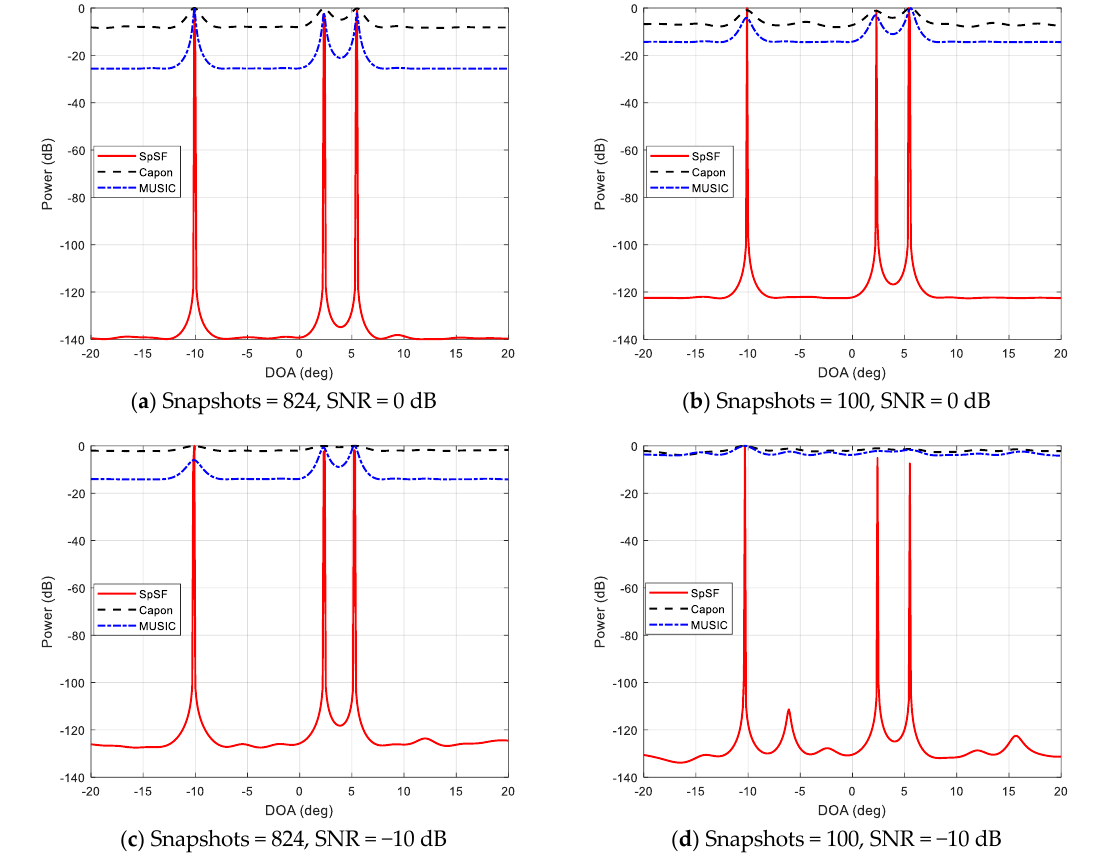
Figure 8. Angle estimation of the simulated data.